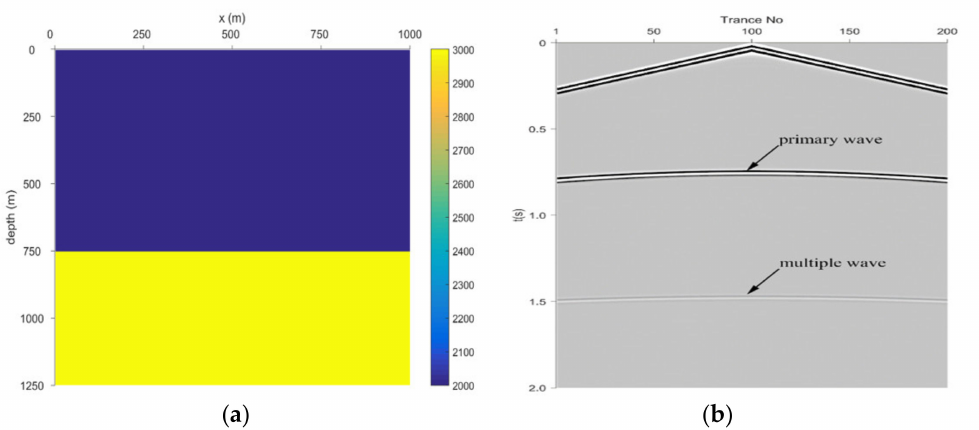
Figure 1. Velocity model and its simulated wavefields. ( a ) Layered velocity model; and ( b ) shot gather containing primary and multiples waves.